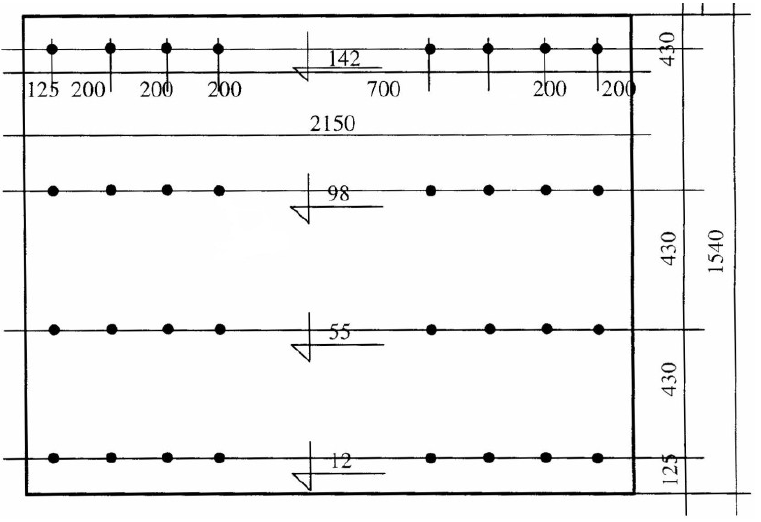
Figure 3. Detail dimensions of experimental wall element (mm).